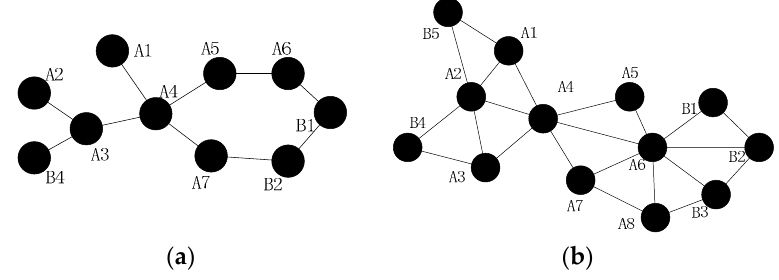
Figure 3. ( a ) With orphan adjacent node; and ( b ) without orphan neighbor.